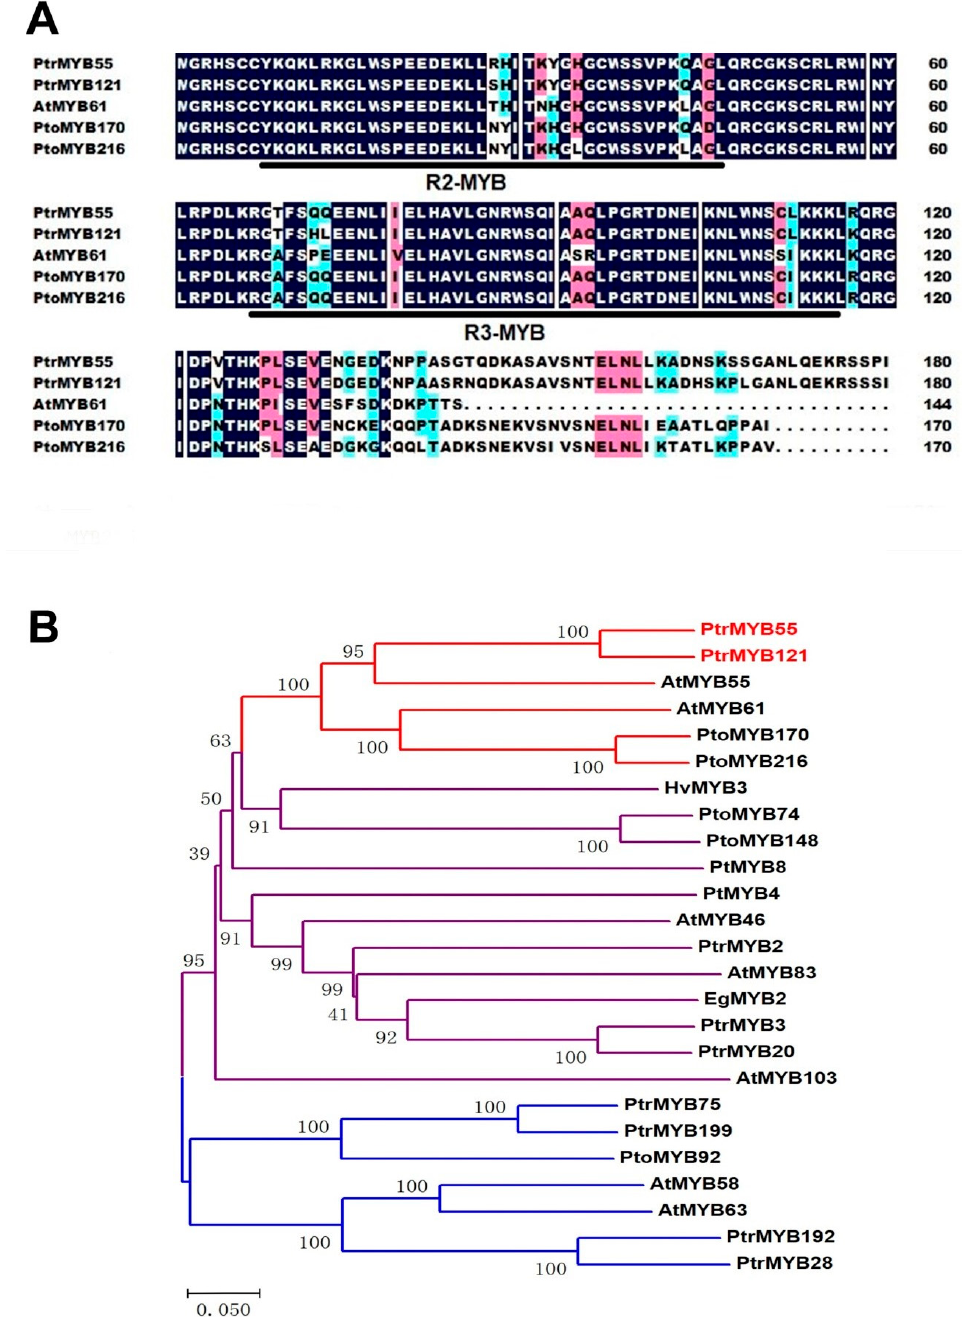
Figure 1. Sequence alignment and phylogenetic analysis of PtrMYB55 and PtrMYB121 . ( A ) Amino acid sequence alignment of the N-terminal region of PtrMYB55 and PtrMYB121 ( P. trichocarpa ) with AtMYB61 ( A. thaliana ), PtoMYB170 ( Populus tomentosa ), and PtoMYB216 ( Populus tomentosa ). The amino acid sequences were aligned with DNAMAN software. The conserved R2 and R3 domains are underlined. Blue and pink shades are used to indicate the similarity of amino acid residues, which is 75–100% and 50–75%, respectively; ( B ) Phylogenetic analysis of PtrMYB55 and PtrMYB121 with R2R3-MYB TFs involved in secondary cell wall (SCW) formation in vascular plants. Phylogenetic tree was analyzed with MEGA8.0. Bar = 0.050 substitutions per site. PtrMYB55 and PtrMYB121 and its homologous genes are highlighted with red lines. The GenBank accession numbers of these R2R3-MYB TFs are listed in Materials and